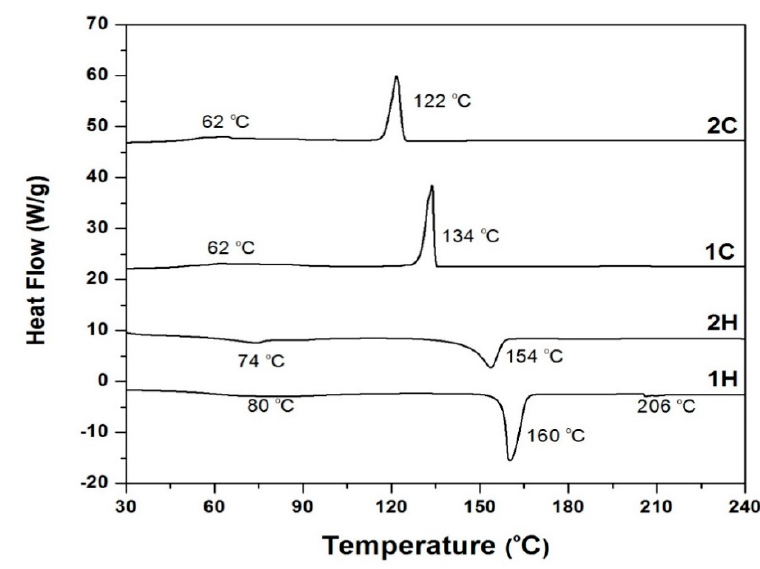
Figure 6. DSC thermograms of V18 obtained at heating and cooling rates of 10 °C/min in nitrogen.